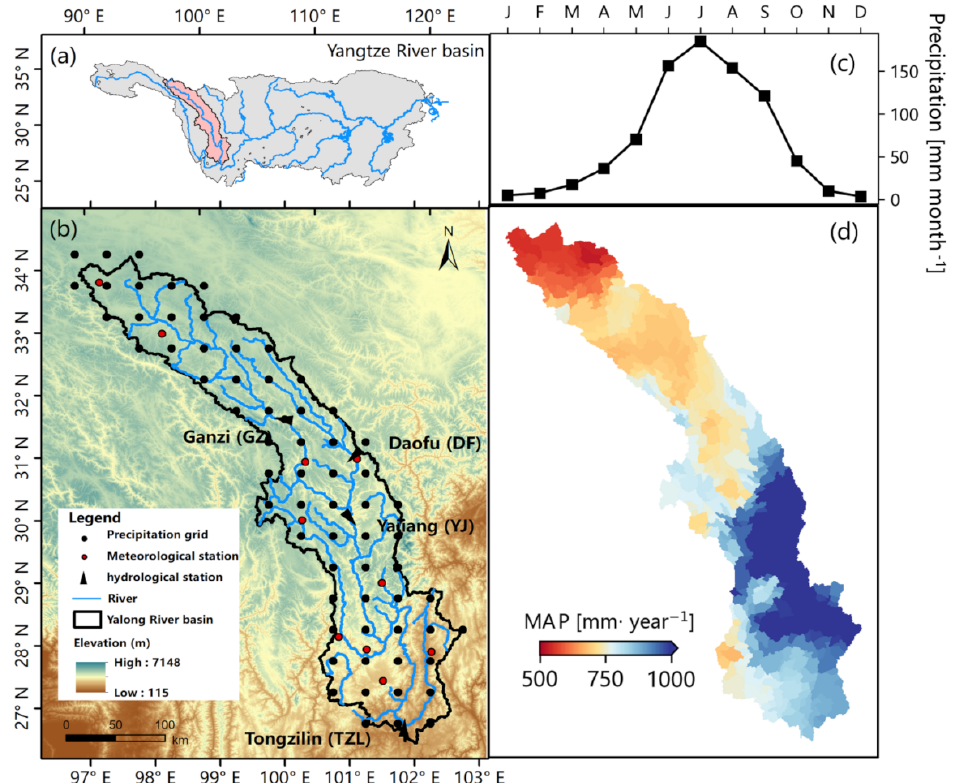
Figure 1. ( a ) The location of the Yalong River basin. ( b ) The terrain and gauge distribution in the Yalong River basin. ( c ) Basin-averaged precipitation climatology for 2003–2019. ( d ) Spatial distribution of mean annual precipitation (MAP) for 2003–2019.